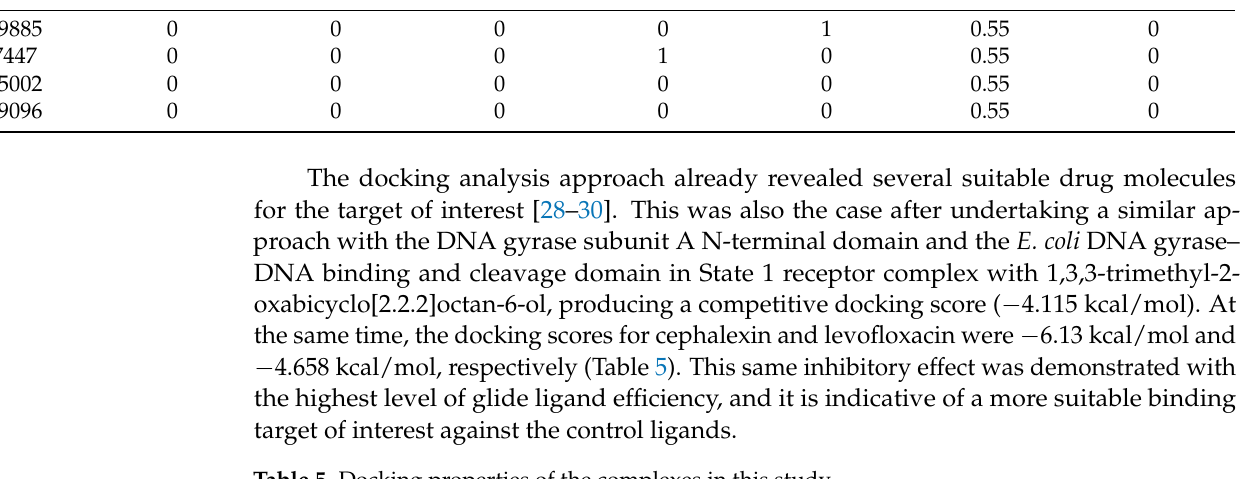
Table 5. Docking properties of the complexes in this